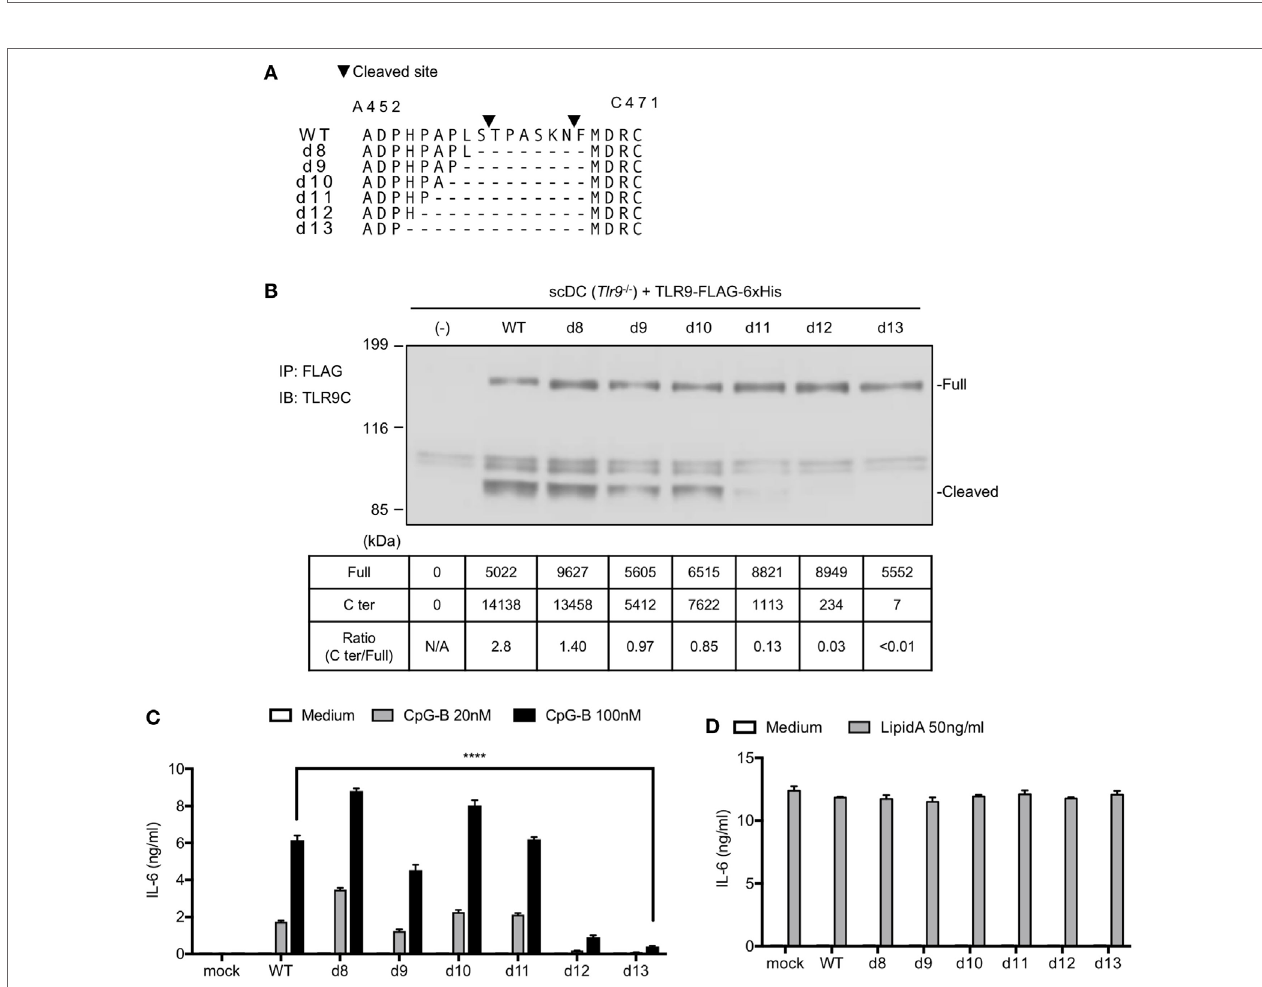
FigUre 2 | Unc93 homolog B1 ( Unc93b1 ) controls the cleavage of toll-like receptor 9 (TLR9) in primary immune cells. (a–c) Gating strategy of splenocytes. Splenocytes were stained with indicated antibodies and analyzed by flow cytometry. Gated cells with arrows were drilled down and analyzed by other markers. Whole cDCs were gated out and the other cells were shown in (c) . (D) Intracellular TLR9 in B cell, CD8 α + cDC, CD8 α − cDC, monocytes, and neutrophil were stained by anti-TLR9 (J15A7, open histogram) or IgG1 isotype control (tinted histogram). The surface markers of these cells were shown in (a–c) . (e) Form of full length (Full) or cleaved C-terminal of endogenous TLR9. The endogenous TLR9 of bone marrow-derived cDCs from WT, Ifnar1 − / − , Unc93b1 D34A/D34A , Unc93b1 − / − , or Tlr9 − / − mice were immunoprecipitated and detected. β -actin in whole cell lysate (WCL) was detected as an internal control. The intensity of the bands was quantified and shown in the table. At least each four mice (a–D) , sex, and age matched were used. At least three times of experiments were performed independently (e) . Abbreviations: ND, not detected; N/A, not